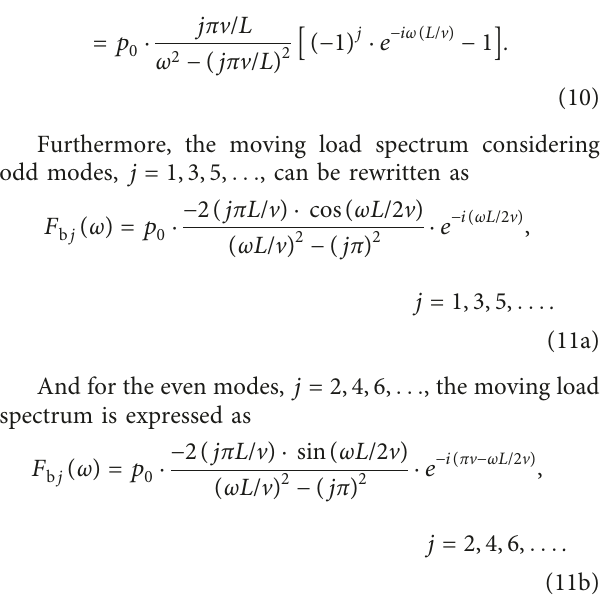
Figure 1: Bridge under a moving constant